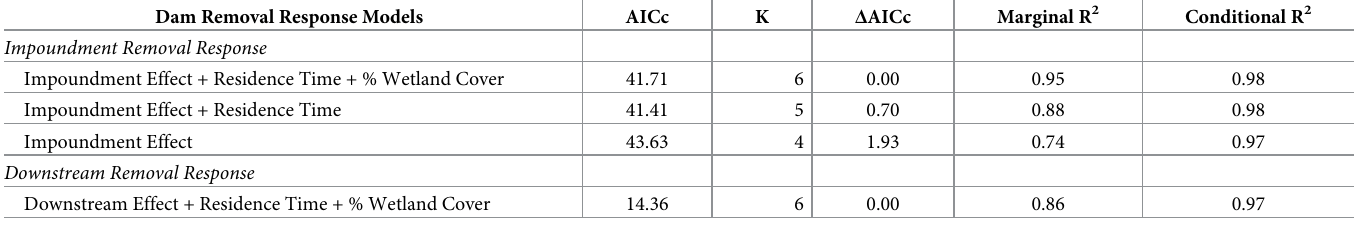
Table 8. Highly ranked linear models ( Δ AIC � 2.0) explaining the variation in impoundment and downstream dissolved oxygen (DO) responses after dam